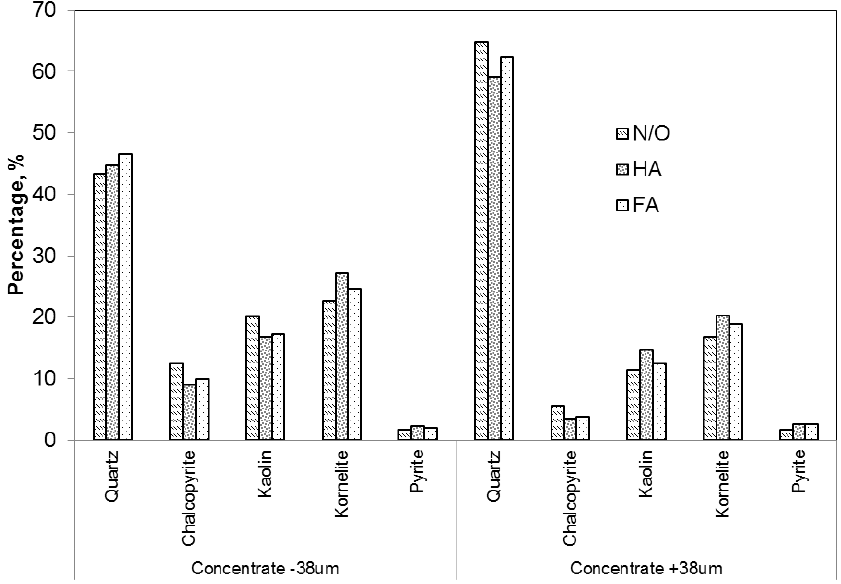
Figure 4. XRD analysis of species present in the bulk Cu–Mo concentrates without (N/O) and with 20 mg/L of humic acid (HA) or fulvic acid (FA).